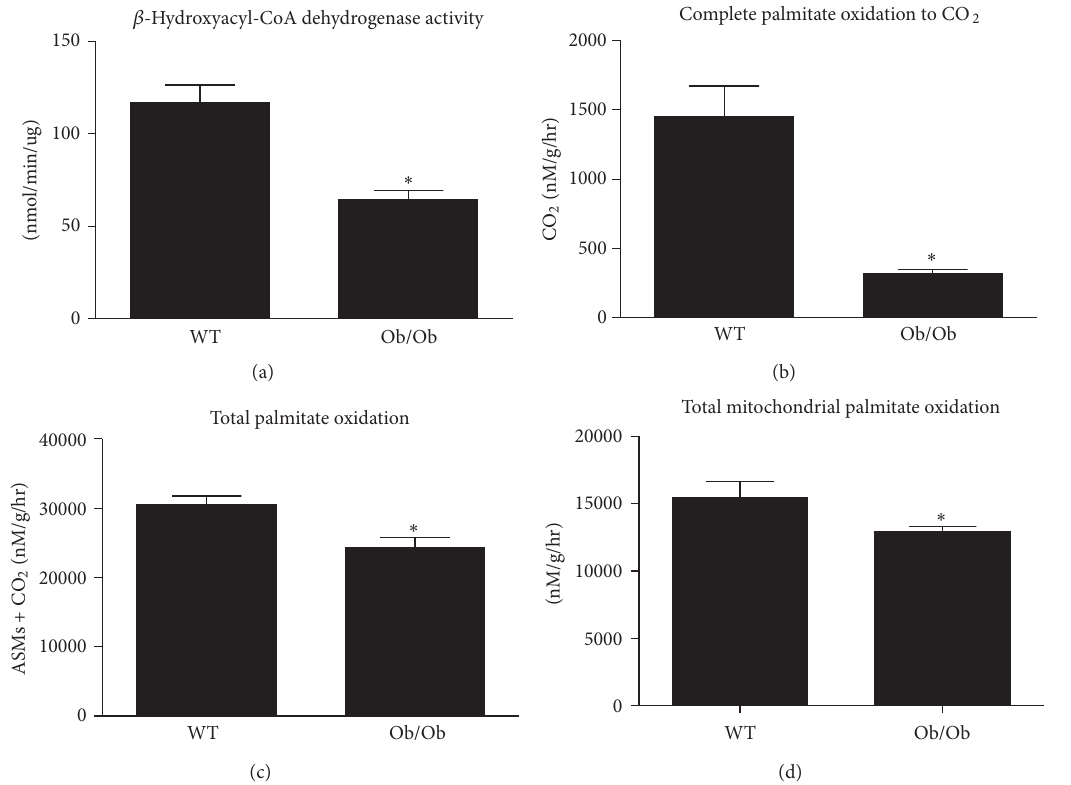
F 5: Hepatic mitochondrial function is reduced in Ob/Ob mice. Hepatic mitochondrial and total palmitate oxidation (c) were determined in fresh liver homogenate preparations from age-matched wild-type (WT) and Ob/Ob mice. Values are means SE ( ± 𝑛𝑛 𝑛 𝑛